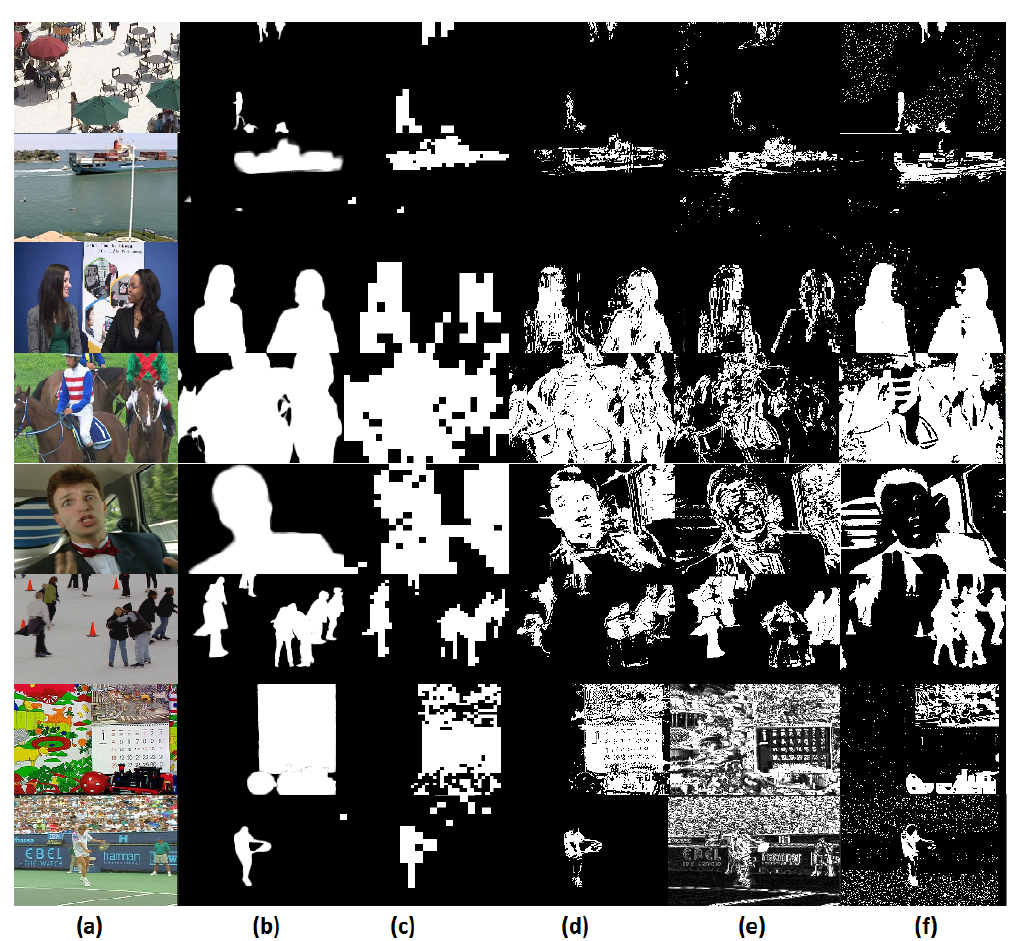
Figure 11. Visual effect comparisons through different methods on HEVC/AVC test sequences. ( a ) Original frames. ( b ) Ground truth. ( c ) Motion vector mask. ( d ) The proposed method. ( e ) SSGodec [29]. ( f ) Sigma-Delta